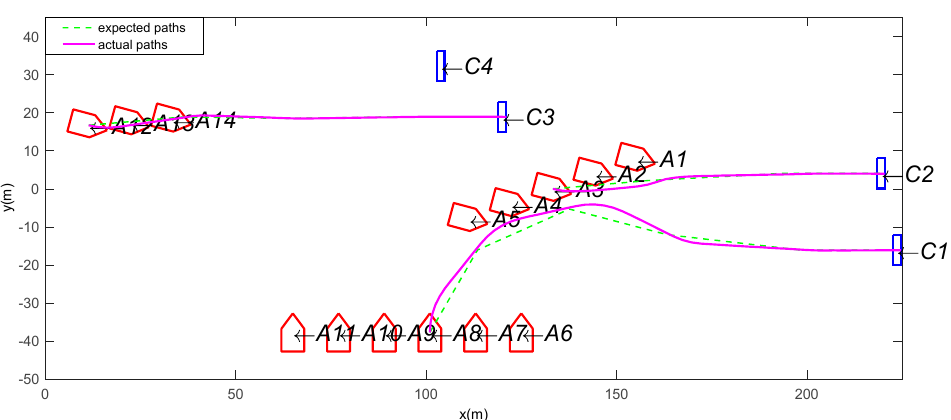
Figure 10. The taxi paths of A 2 , A 4 and A 13 .